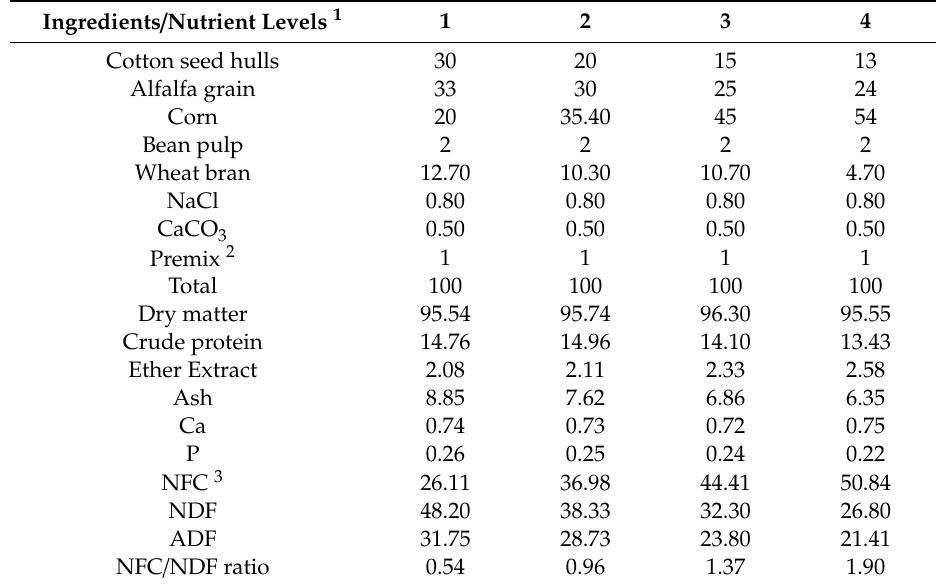
Table 1. The ingredients and nutrient composition of the diet (% of dry matter). Ingredients / Nutrient Levels